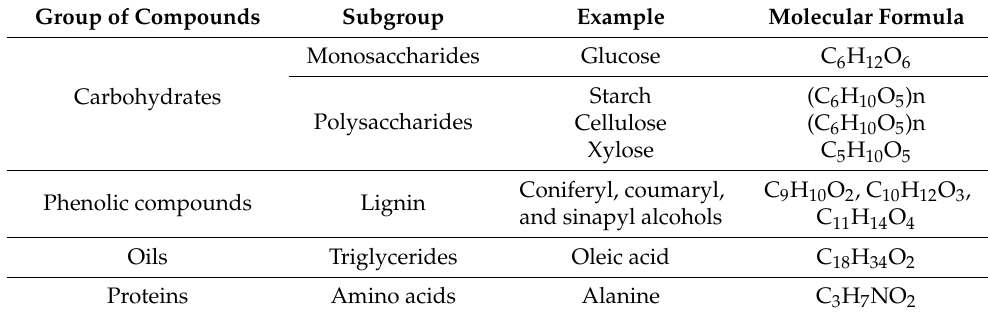
Table 1. Major biomass components [11].